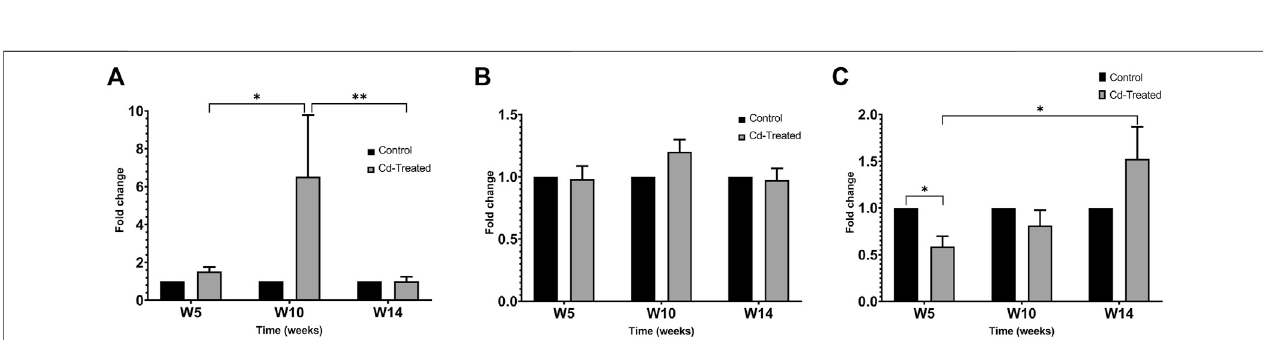
Frontiers in Pharmacology |